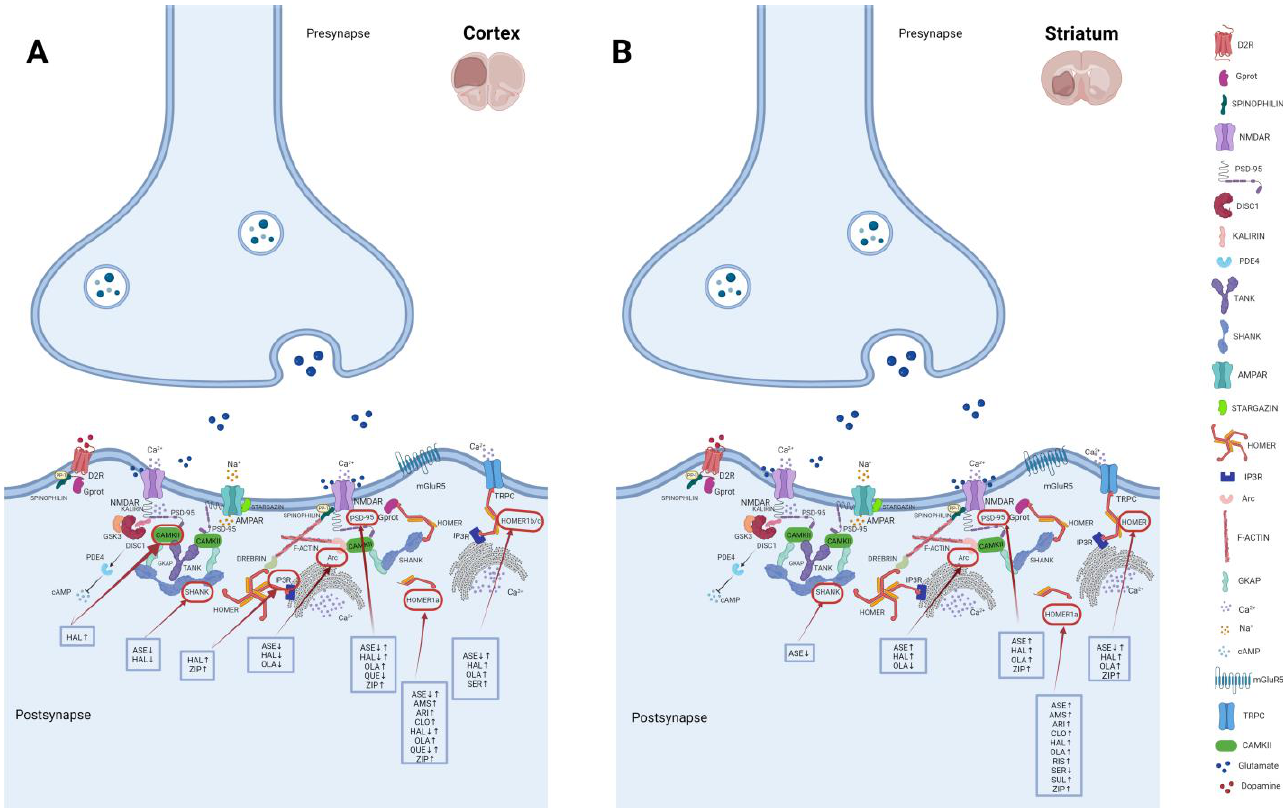
Figure 4. Antipsychotics and PSD modulation as relevant unconventional antipsychotic action. Panel ( A ). Modulation of PSD proteins by antipsychotics in rat cortical regions. Panel ( B ). Modulation of PSD proteins by antipsychotics in rat striatal regions. AMPAR = α-amino-3-hydroxy-5-methyl-4-isoxazolepropionic acid receptor; CAMKII = Calcium–calmodulin (CaM)-dependent protein kinase II; F-ACTIN = Filamentous actin; GKAP = guanylate kinase-associated protein; GSK3 = Gly-